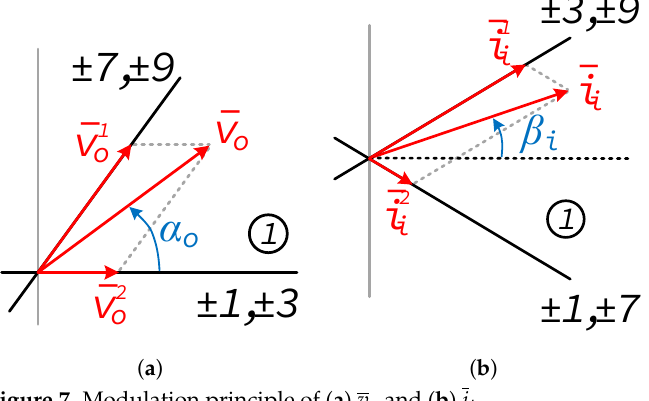
Figure 7. Modulation principle of ( a ) v o and ( b ) i i